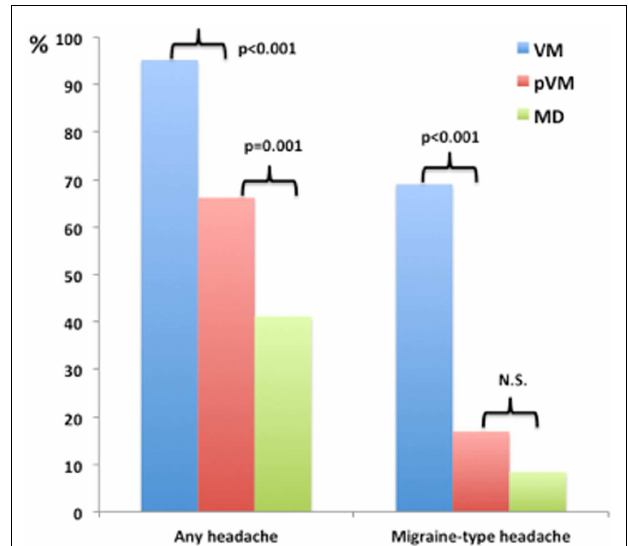
FIGURE 1 | Relative frequency of headache and migraine-type headache during the episode of vestibular symptoms among patients with Menière’s disease (MD), vestibular migraine (VM), and probable VM (pVM)